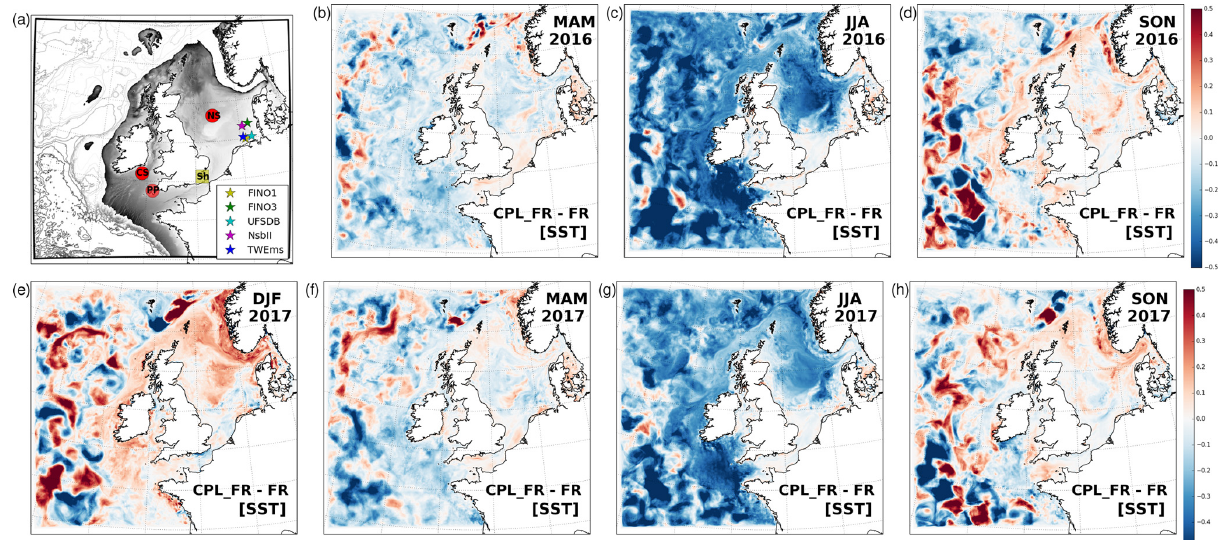
Figure 3. (a) Illustration of AMM15 model bathymetry (see Tonani et al., 2019, for more details) and location of NWS observing sites referenced in the paper. The filled-shading region indicates where model bathymetry in less than 200m depth and highlights the region on the shelf. Elsewhere contour lines are drawn every 500m depth. Filled circles are at “Celtic Sea”, “Perranporth” and “North Sea” sites (see Sect. 4.1, 4.3). Starred locations in the German Bight are listed in the legend (see Sect. 4.2, 4.4). The yellow square is the “Sheerness” tide gauge (see Sect. 4.5). (b–h) Difference in seasonal mean SST (CPL_FR minus FR) due to wave coupling calculated as 3-month means from spring 2016 to autumn